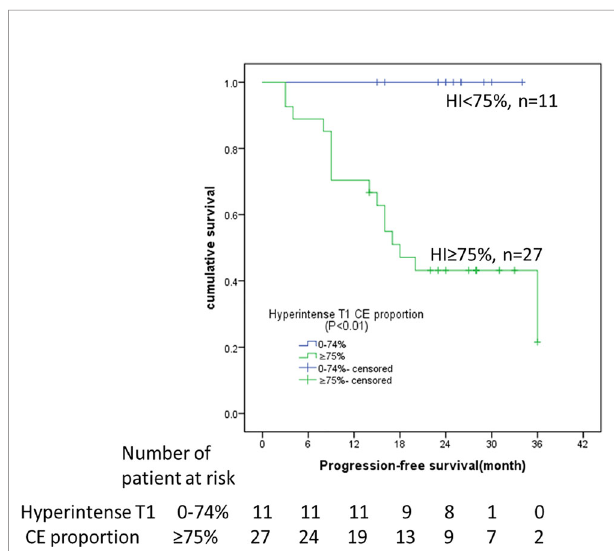
FIGURE 4 | Kaplan – Meier analyses of PFS in 38 DF patients with imatinib treatment. Patients strati fi ed by hyperintense T1 CE proportion (<75 vs . ≥ 75%) on pre-therapy MRI. HI, hyperintense T1 CE proportion; CE, contrast